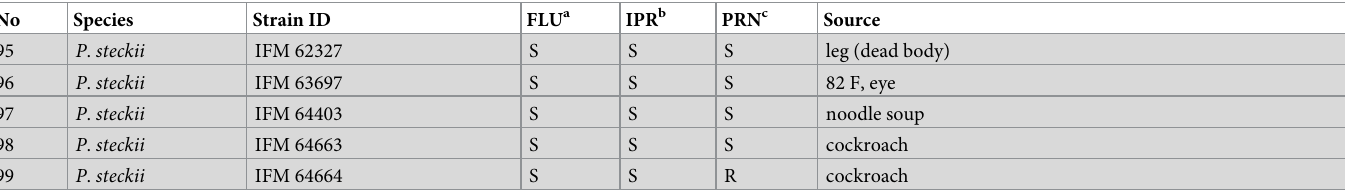
a FLU indicates fludioxonil: S and R indicate sensitive and resistant, respectively. b IPR indicates iprodione. c PRN indicates pyrrolnitrin.